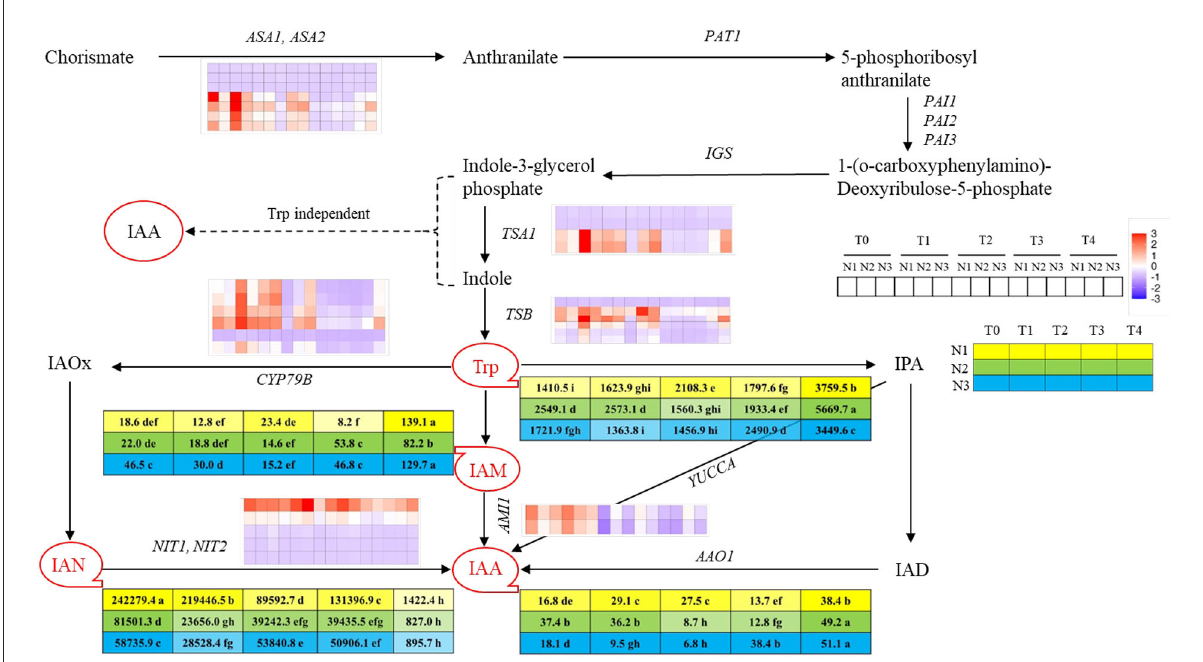
FIGURE3 Overview of auxin and derivatives and genes involved in auxin biosynthesis pathway at T0, T1, T2, T3, and T4 stages under low N (N1), normal N (N2), and high N (N3) rates. IAA, Indole-3-acetic acid; IAN, 3-Indole acetonitrile; IAM, 3-Indole acetamide; Trp, tryptophan. Red circles with tails represented different auxin-derivatitves and the 5 × 3 matrix represented the contents under 3N rates at five sampling stages. Color bars represent the trends of expression levels after centralization and standardization by the R programming language, red color represents higher expression, while purple represents lower expression relatively. Tables near Trp, IAM, IAN, and IAA represent each content (ngg − 1 ) at T0, T1, T2, T3, and T4 stages under N1, N2, and N3 rates, and yellow, green and blue colors represent different N rates, while the color shades reflected the level of the contents. Dash lines indicated the supposed pathway of auxin biosynthesis while the solid line showed the detected pathway of auxin biosynthesis. Lower case behind the numbers in the tables represented significant differences, p ≤